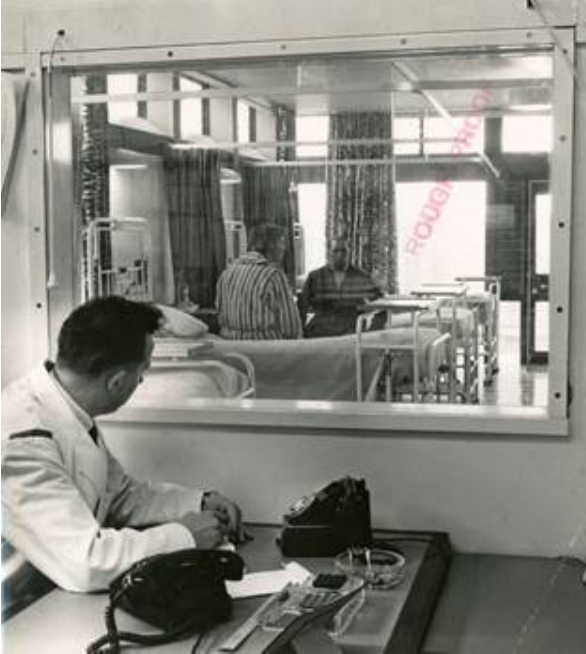
Figure 9. Post-war Admission Villa, Fulbourn Hospital, Cambridgeshire, ward, 1964 (Source: ‘Photographs taken at the opening of Kent House by Princess Marina, Duchess of Kent, 1964’, KHF/6/1/15, Cambridgeshire Archive Services, Ely, Cambridgeshire,